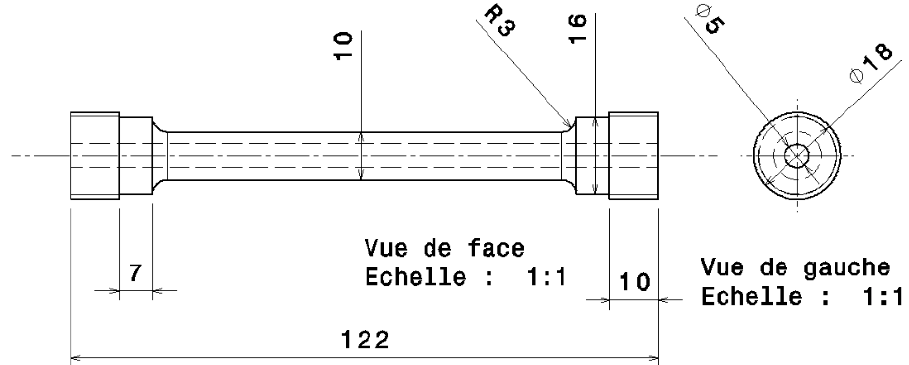
Figure 4. Technical drawing of TMF samples (size in mm).